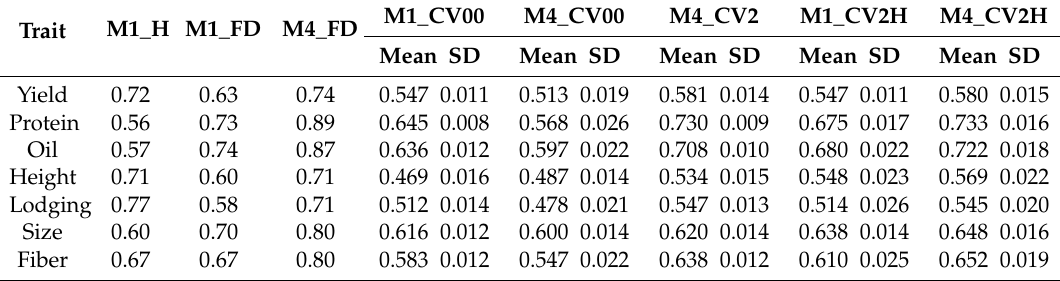
Table 4. The square root of the heritability (H), the goodness of fit using single-trait (M1_FD) and multi-trait (M4_FD) models, and the average predictive ability (20 replicates) of unobserved records for 7 traits using di ff erent prediction strategies: M1_CV00, single-trait genomic prediction with 50% of missing values per trait; M1_CV2H, single-trait genomic prediction with 75% of missing values for traits other than yield (50%); M4_CV00, multi-trait genomic prediction model with 50% of missing values across traits; M4_CV2, multi-trait genomic prediction model with 50% of the genotypes partially observed (i.e., some traits but not others for the same genotype); M4_CV2H, multi-trait genomic prediction with 75% of missing values for traits other than yield